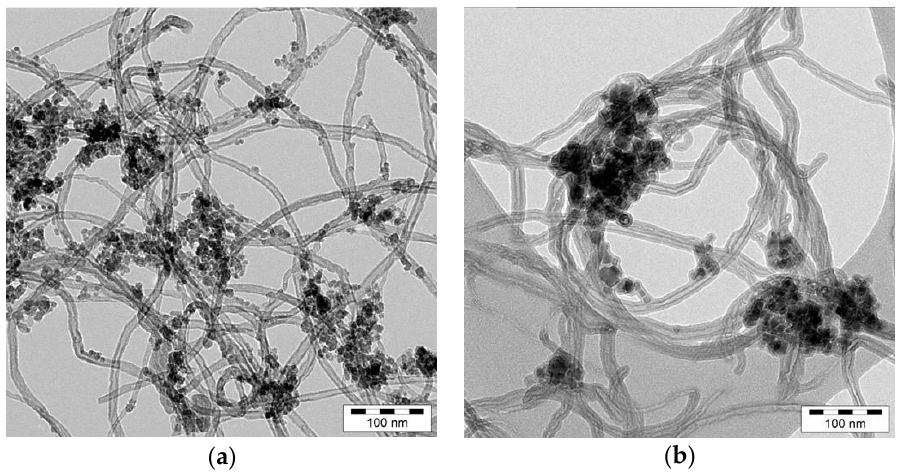
Figure 9. TEM images of Fe 3 O 4 deposited onto oxidized ( a ) or pristine ( b ) MWCNTs using the solvothermal method [16].